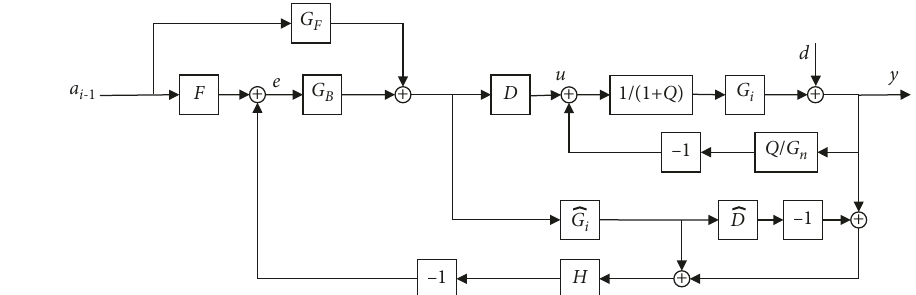
Figure 12: The block diagram of DOB-SPC.